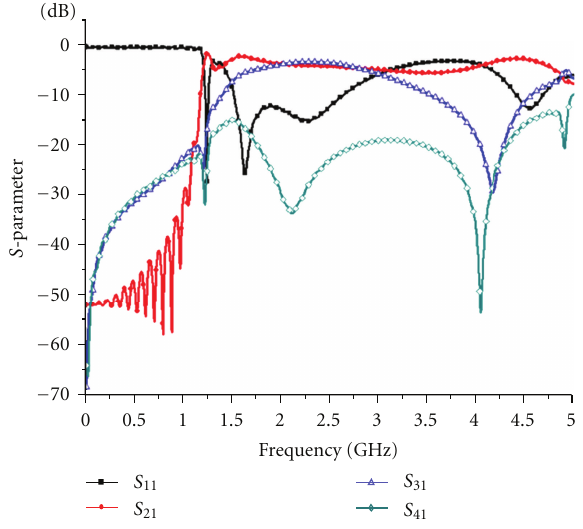
Figure 4: Geometry of the feed network for two-by-two microstrip patch array antenna.